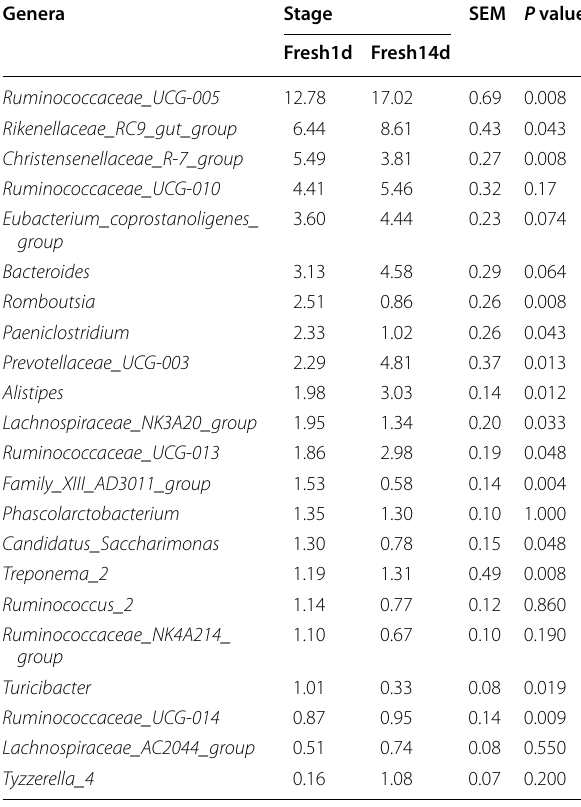
Table 3 Effect of lactation period on diversity at the genus level in the fecal bacterial